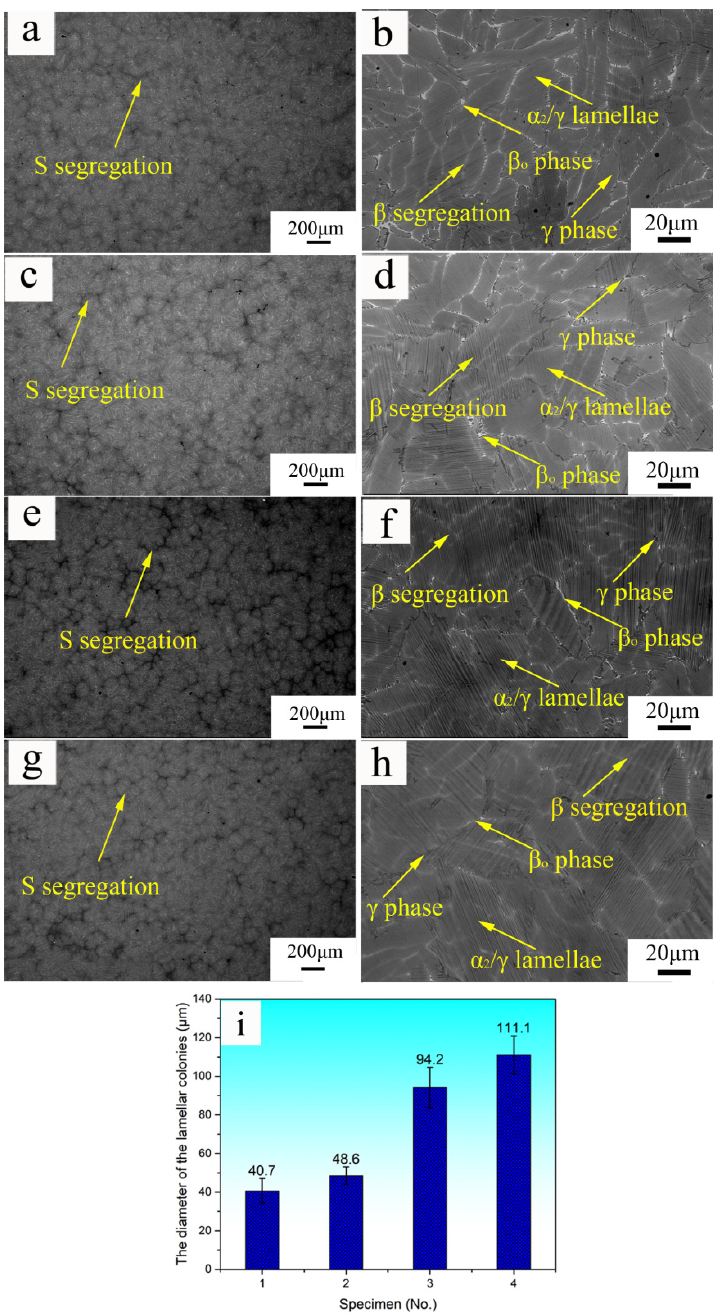
Figure 2. The SEM-BSE images of the following four alloys: S1 ( a , b ), S2 ( c , d ), S3 ( e , f ) and S4 ( g , h ), respectively, and the diameter of their lamellar colonies ( i ).